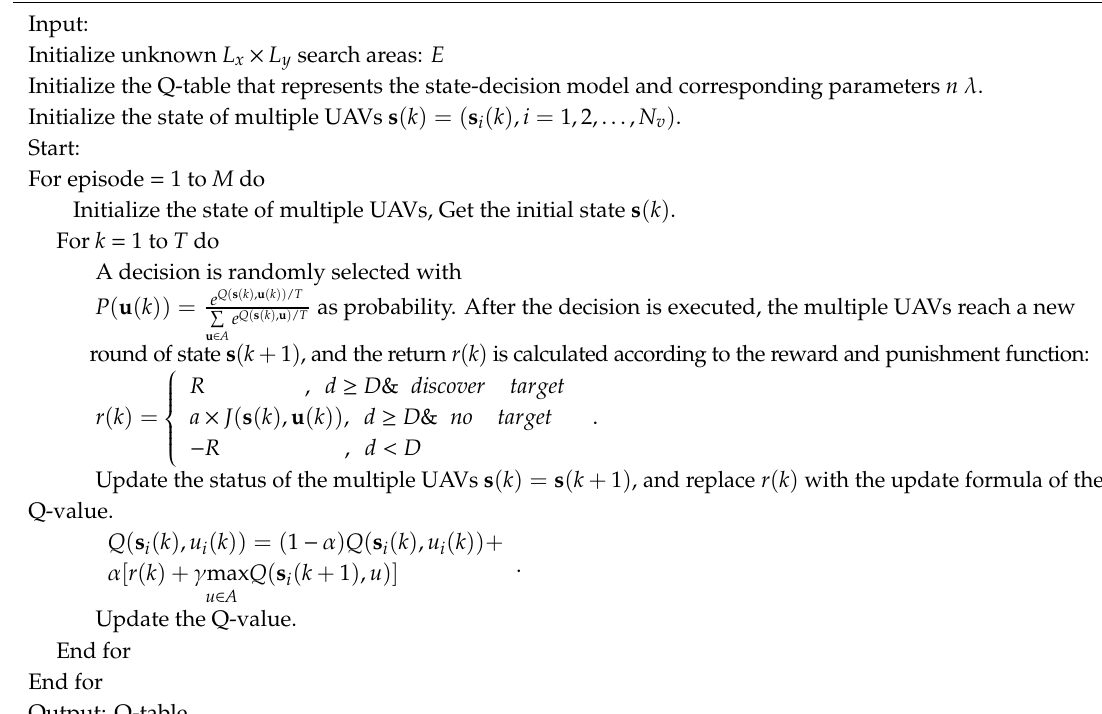
Algorithm 1 Q-Learning of cooperative